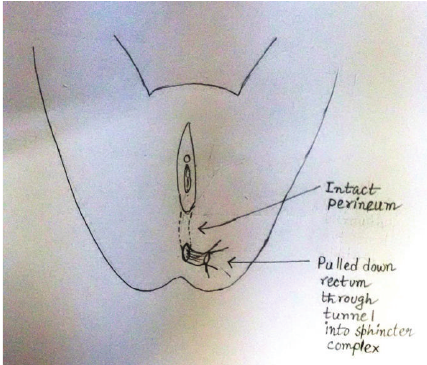
Figure 12: Rectum transposed.